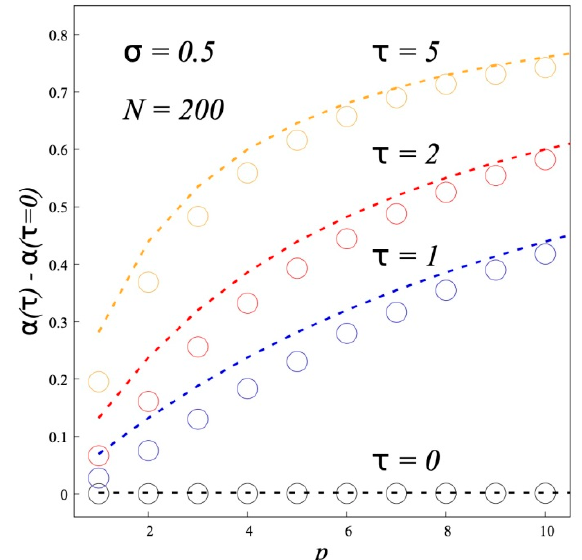
Figure 8. The fraction of “hairpins” α as a function of the statistical segment length p of the grafted chains. Dotted lines indicate theoretical curves, symbols indicate SF-SCF calculation results ( σ = 0.5, N = 200).